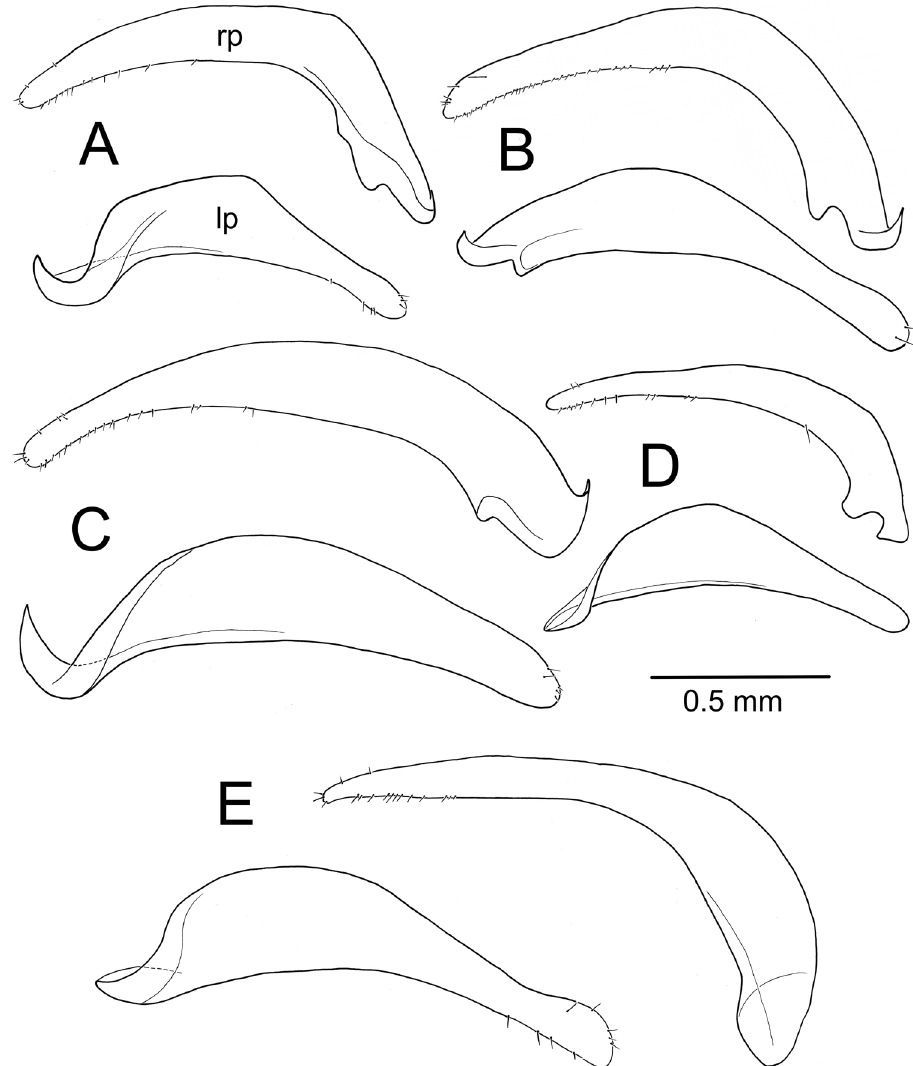
Figure 5. Parameres of male aedeagus for Theprisa spp., outside lateral view. Right paramere shown above left paramere A T. otway B T. convexa C T. montana D T. australis E T. darlingtoni. Abbreviations: lp, left paramere; rp, right